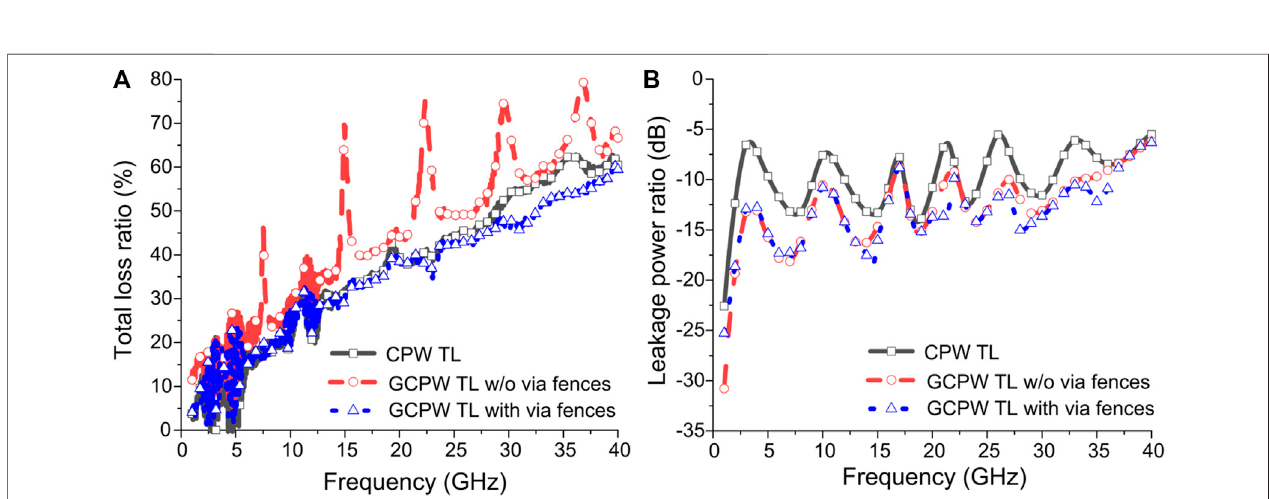
FIGURE 2 | L (cid:2) 10 mm. (A) Measured total loss ratio. (B) Simulated leakage power ratio.